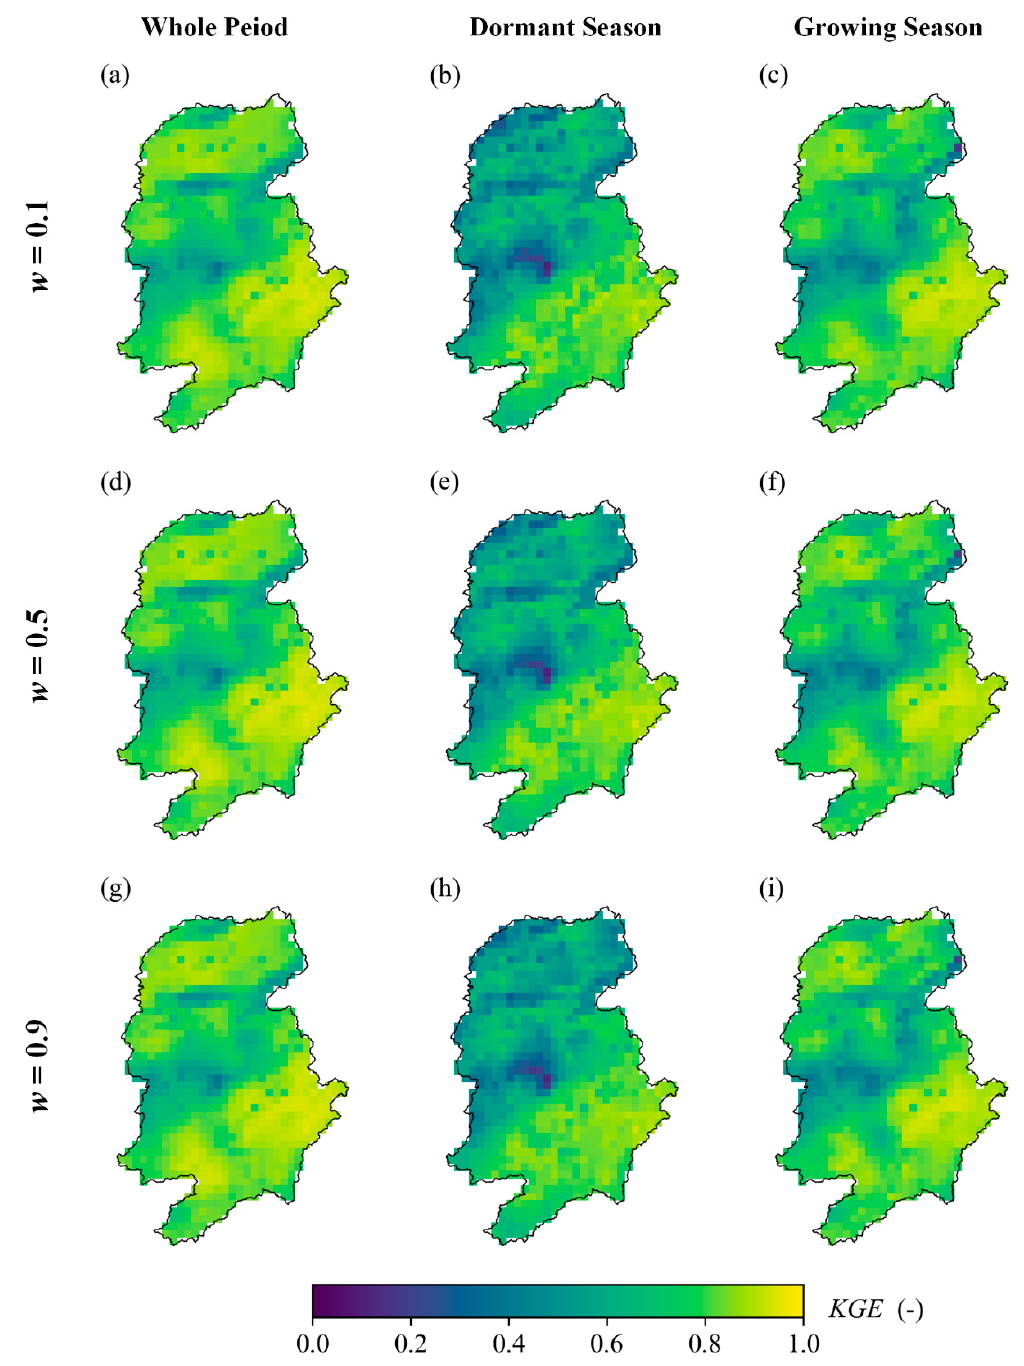
Figure 8. KGE value between cell-based SWI series ( θ SWI ) and DDRM-simulated soil moisture series i ( θ DDRM ) during the whole period (the left column), the dormant seasons (the middle column) and the growing seasons (the right column) under three calibration schemes ( w = 0.1, w = 0.5, w = 0.9, respectively).